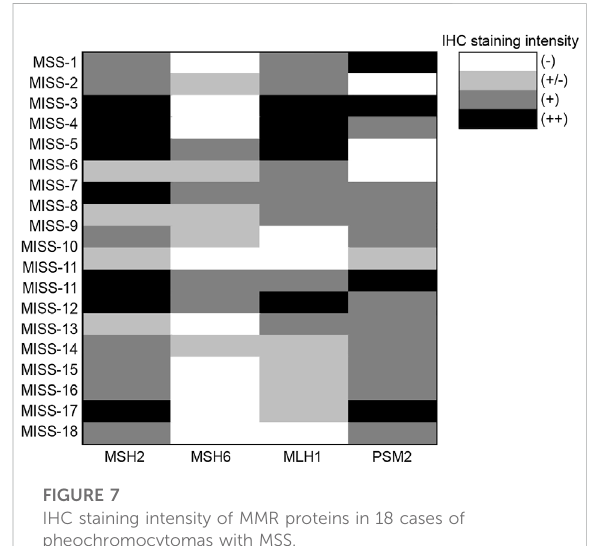
FIGURE 7 IHC staining intensity of MMR proteins in 18 cases of pheochromocytomas with